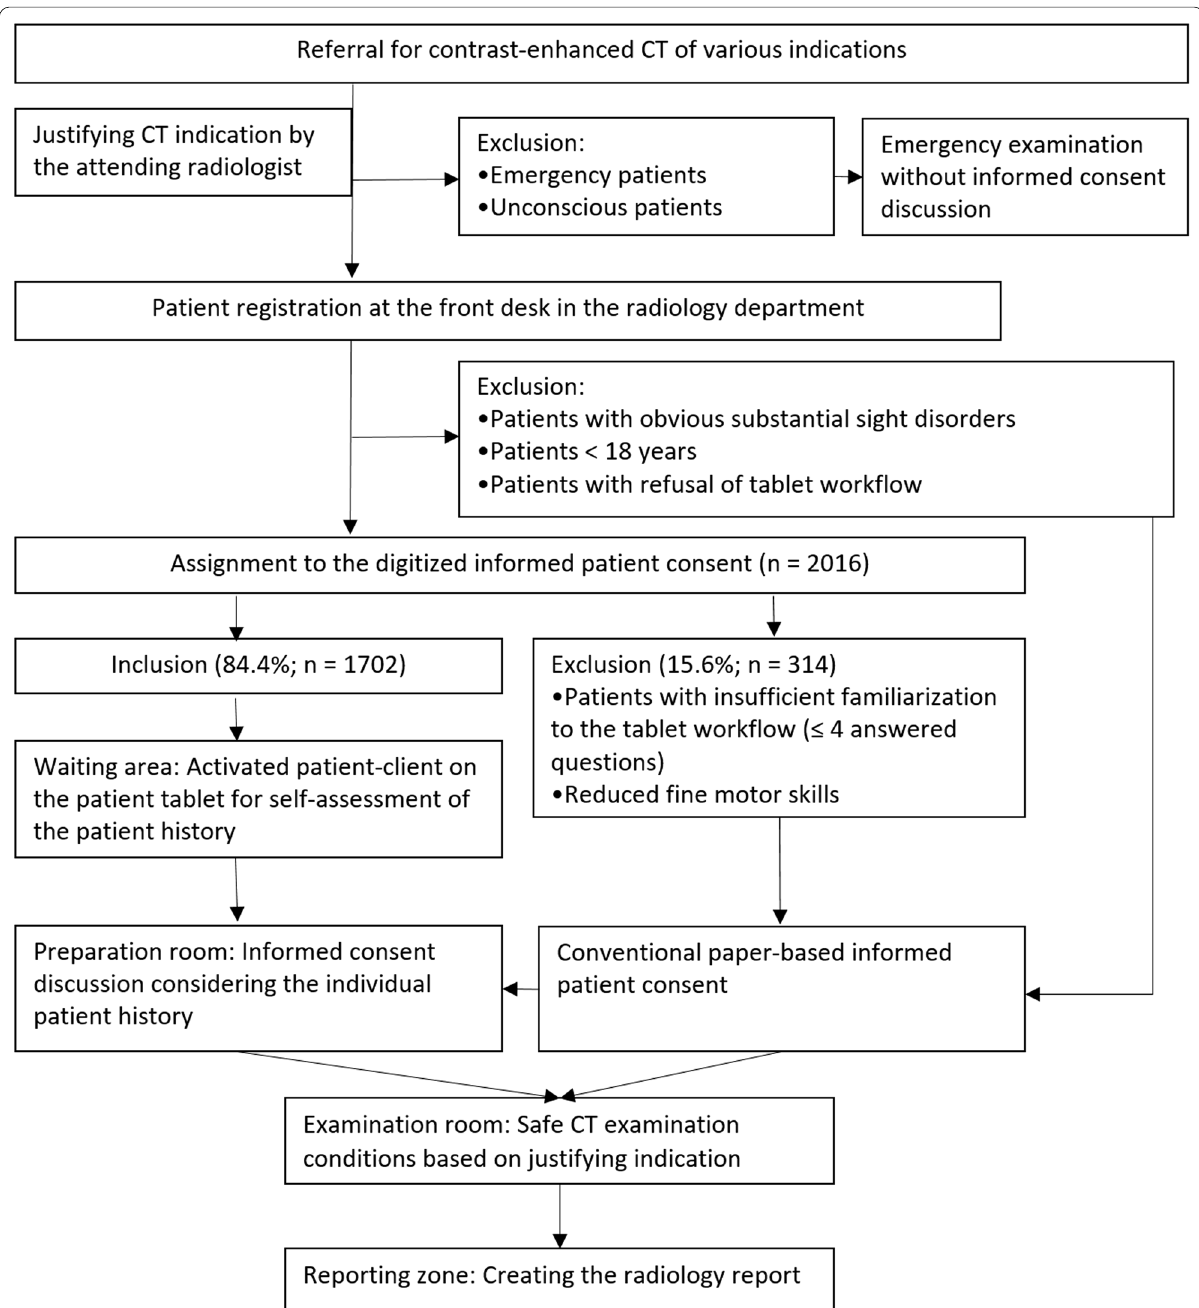
Fig. 1 Study flowchart for tablet-based, digitized informed patient consent (D-IPC). Before the tablet-based workflow started, the indication for CT was evaluated by the attending physician. The patients were then asked to answer a dedicated questionnaire in the waiting room with 22 main items. Structured patient data based on D-IPC was available on all workstations for informed consent discussion and reporting